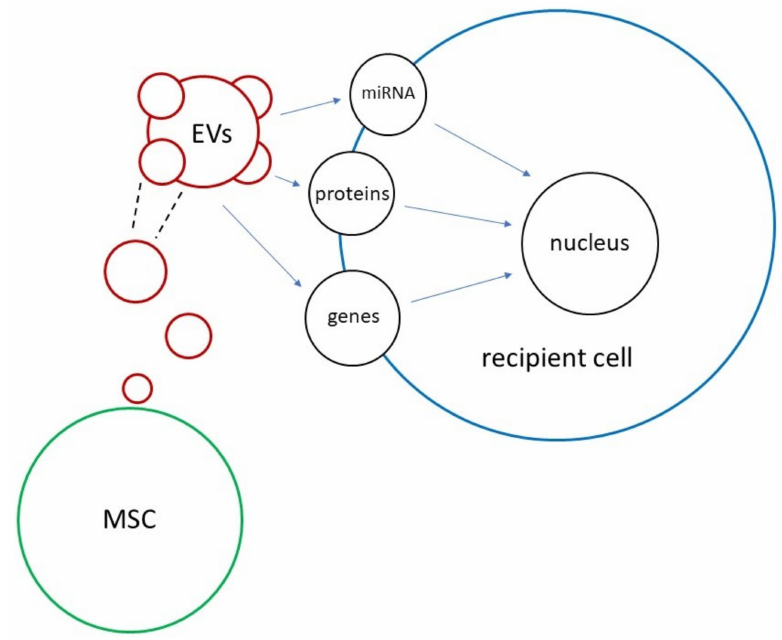
Figure 4. EV-mediated intercellular communication: This diagram shows the mechanism of intercel- lular communication mediated by MSC-induced exosomes. MSCs: mesenchymal stem cells; EVs: extracellular